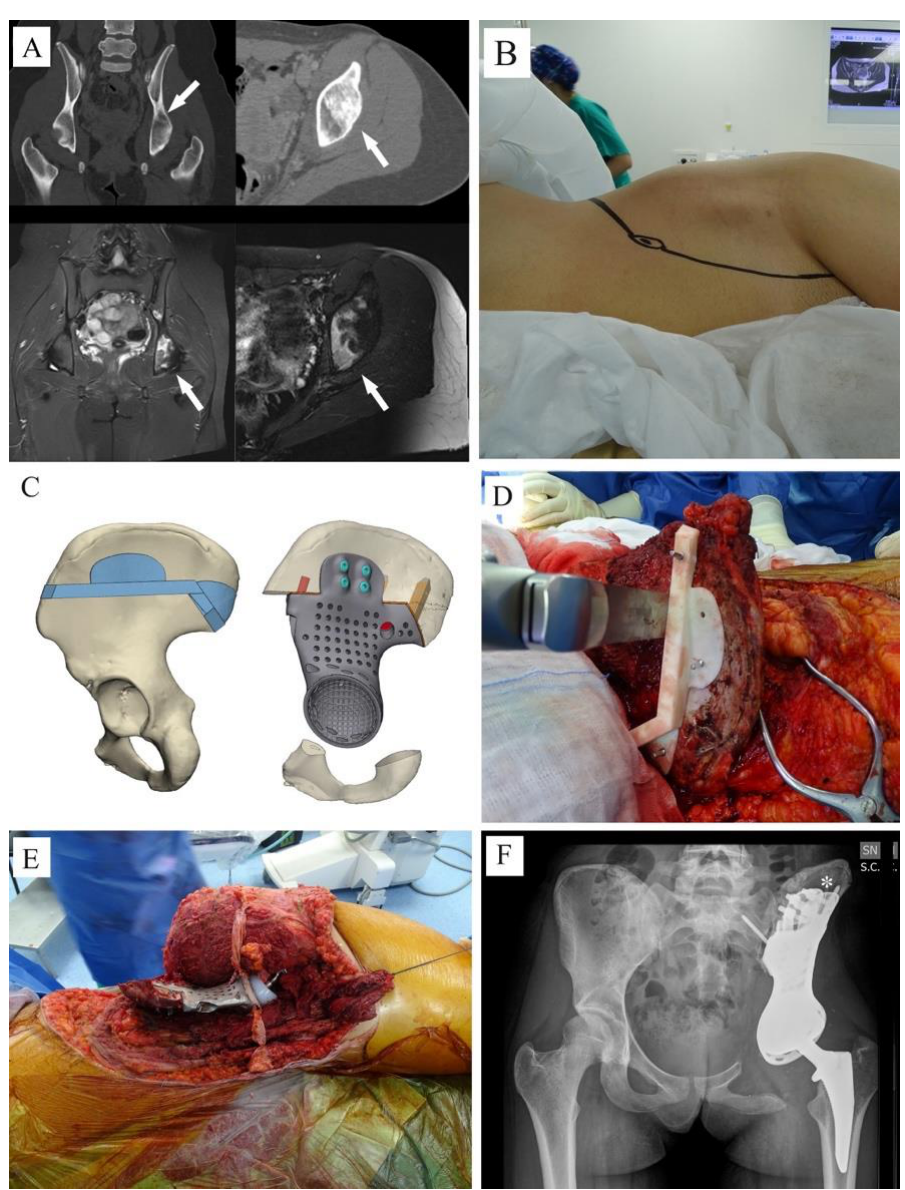
Figure 3. ( A ) CT-scan and MRI showing a Ewing sarcoma involving the acetabulum (white